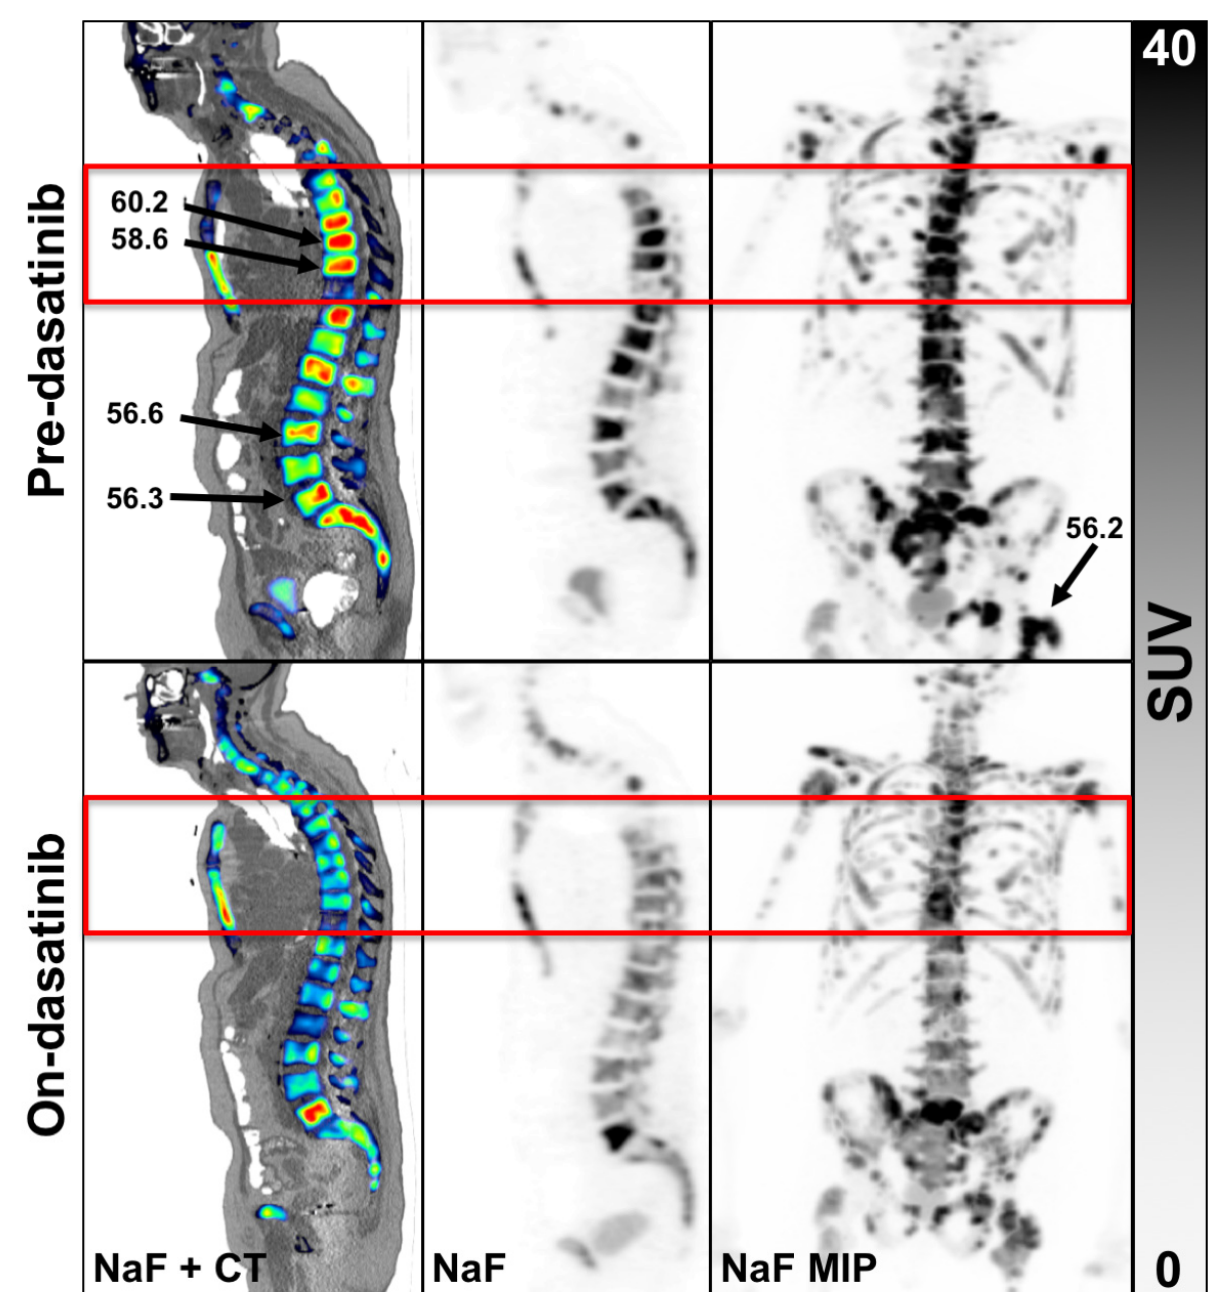
Figure 1. Example of an 82-year-old patient scan 1 ( top row) and scan 2 ( bottom row). Panels left to right, NaF overlaid on CT, NaF alone and with NaF PET maximal image projection (MIP) of the entire WB volume. The red box is the single FOV for the dynamic scan. Three of the 5 hottest tumors were not located in the single dynamic FOV, the results of which were reported previously [8]. An example WB patient with none of the hottest tumors in the dynamic FOV appears in Supplementary Materials Figure S3.